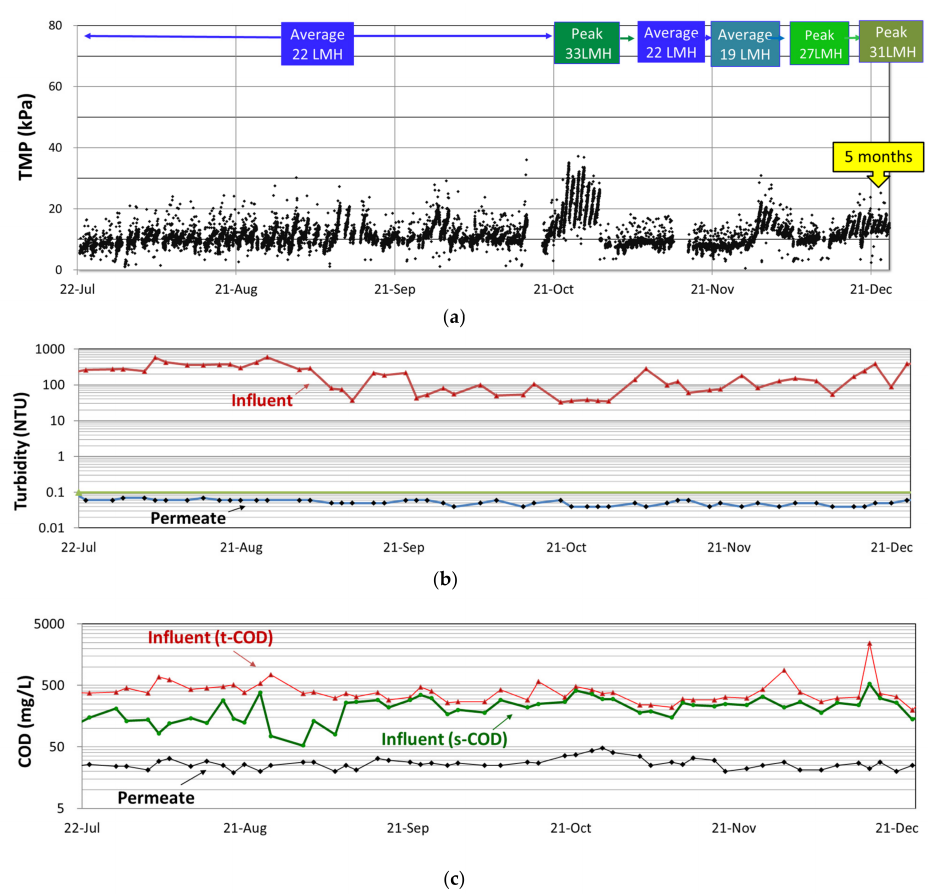
Figure 5. TMP trend, turbidity, and COD of MBR: ( a ) TMP trend with intermittent aerator; ( b ) Tur- bidity; ( c )